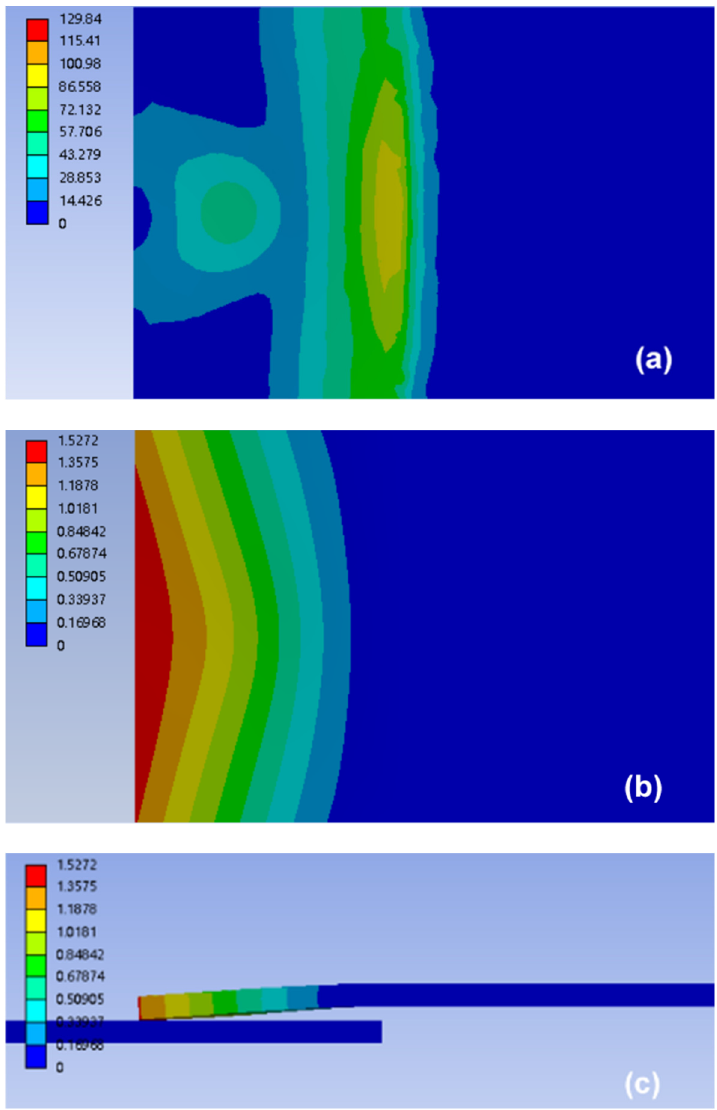
Figure 12. Simulation of stress and deformation of the upper workpiece for joint with gap of 1.5 mm under static pressure: ( a ) stress distribution of upper workpiece (Units in MPa), ( b ) top view, and ( c ) side view of the deformation distribution of the upper workpiece (Units in mm).